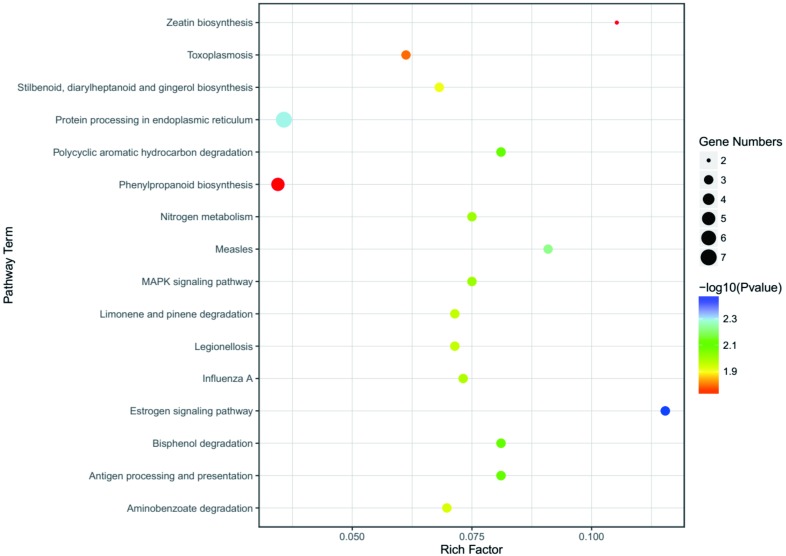
KEGG enrichment analysis of the screened DEGs.The abscissa is the Rich Factor, and the ordinate is the KEGG pathways ID. Circle size represents the number of genes, and circle color represents the P-value.